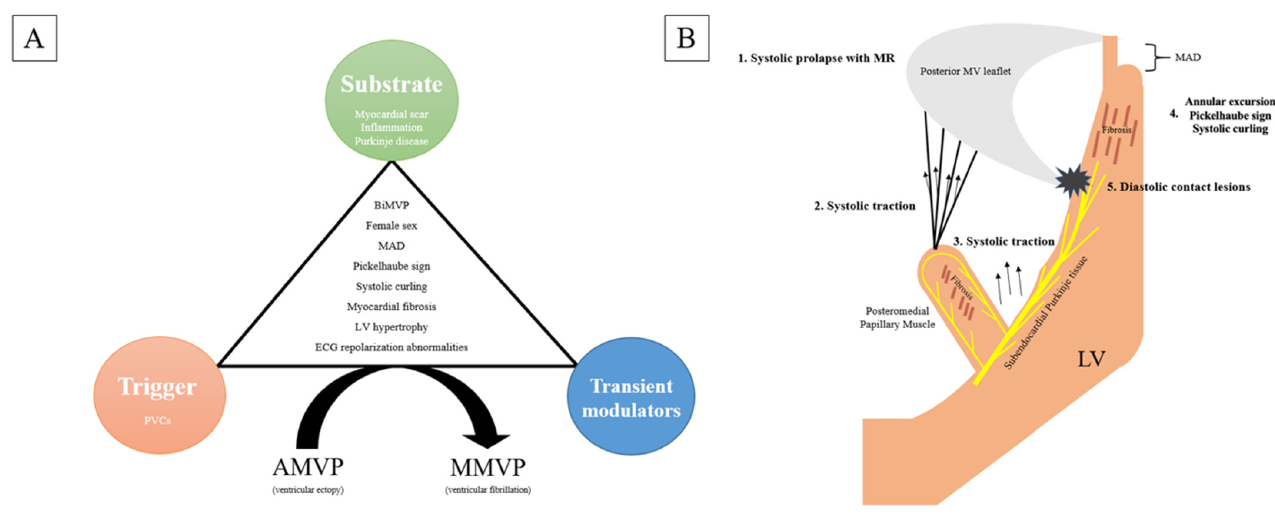
Figure 2. Mechanisms of arrhythmogenesis. ( A ) An interplay of substrate, trigger and transient modulators in the setting of other high-risk features involved in MVP-related SCD. ( B ) Prolapse leads to traction-induced injury of the mitral valve apparatus and its associated Purkinje network.